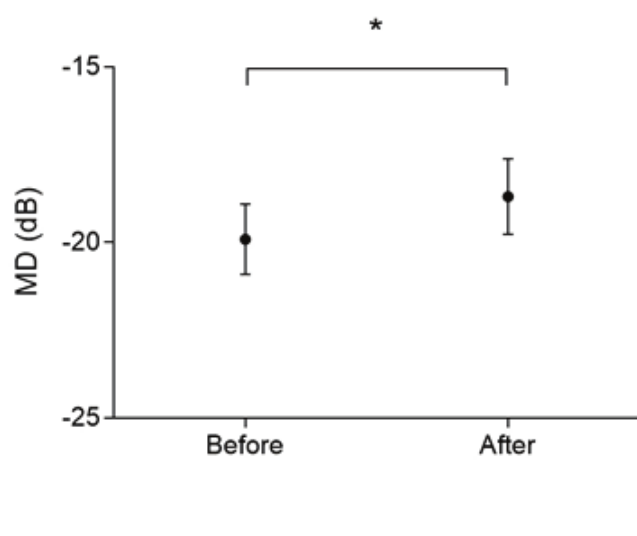
Figure 2. MD changes before and after using the reversed Galilean telescope. Data are presented as Mean ± SEM ( n = 52 subjects). *Denotes a significant